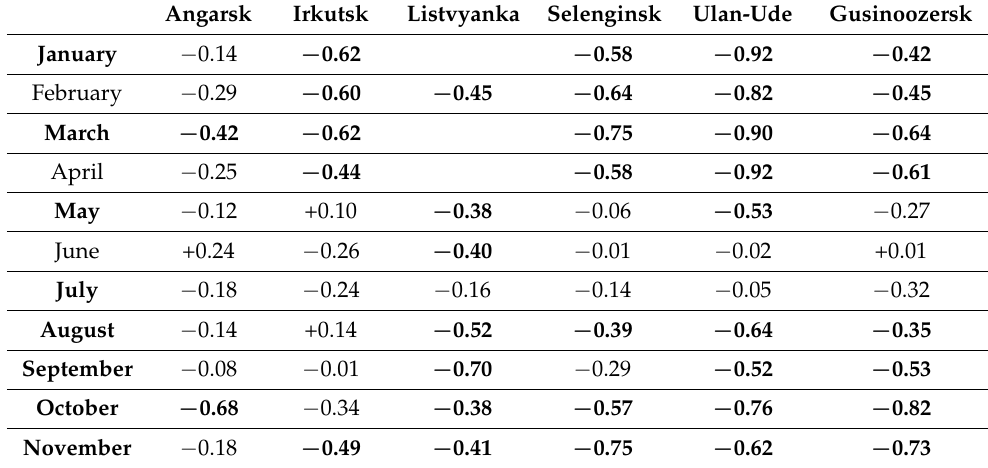
Figure 5. Variability of daily average concentrations of O 3 and NO 2 in Irkutsk ( a ) and Ulan-Ude ( b ) from January to April 2021. Table 2. Correlation coefficient of average daily concentrations of ozone and nitrogen dioxide at atmospheric monitoring sites in